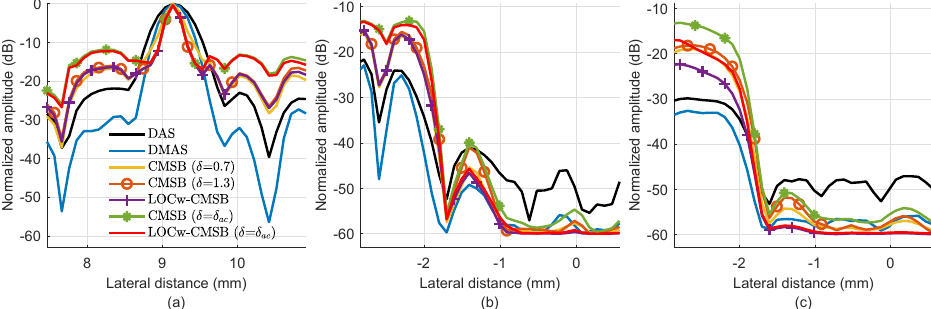
Figure 7. Lateral variations through ( a ) the point target at ( x , z ) = (9.1 mm, 37.6 mm), and ( b , c ) two anechoic cysts in experimental cyst